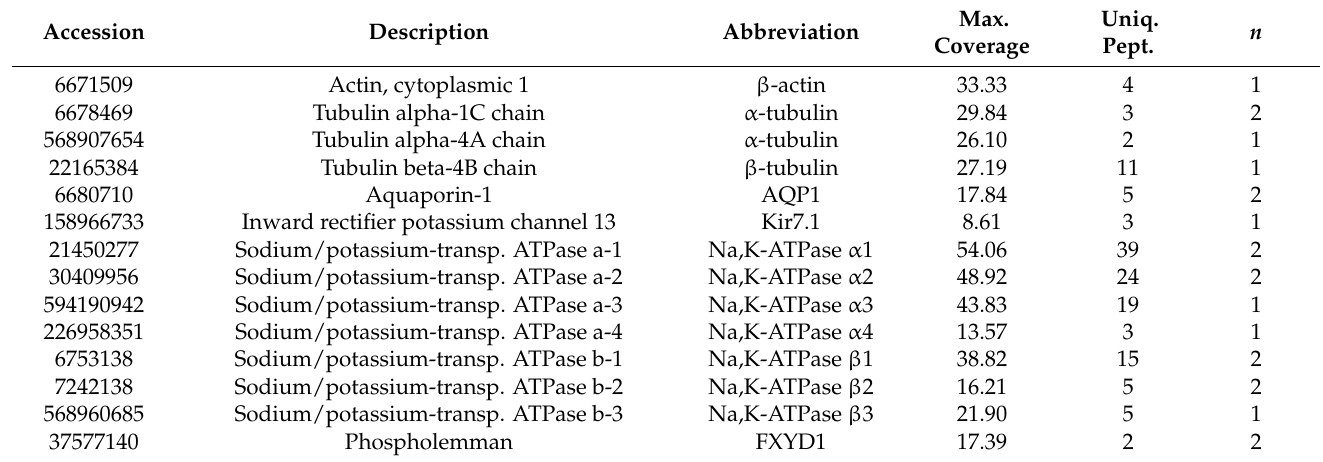
Table 2. Coomassie band near the anti-Na,K-ATPase α 1 immunoreactive band on native PAGE blot. Maximum sequence coverage (Max. Coverage), Unique peptides (Uniq. Pept.), number of identifications (of five replicates, n ).